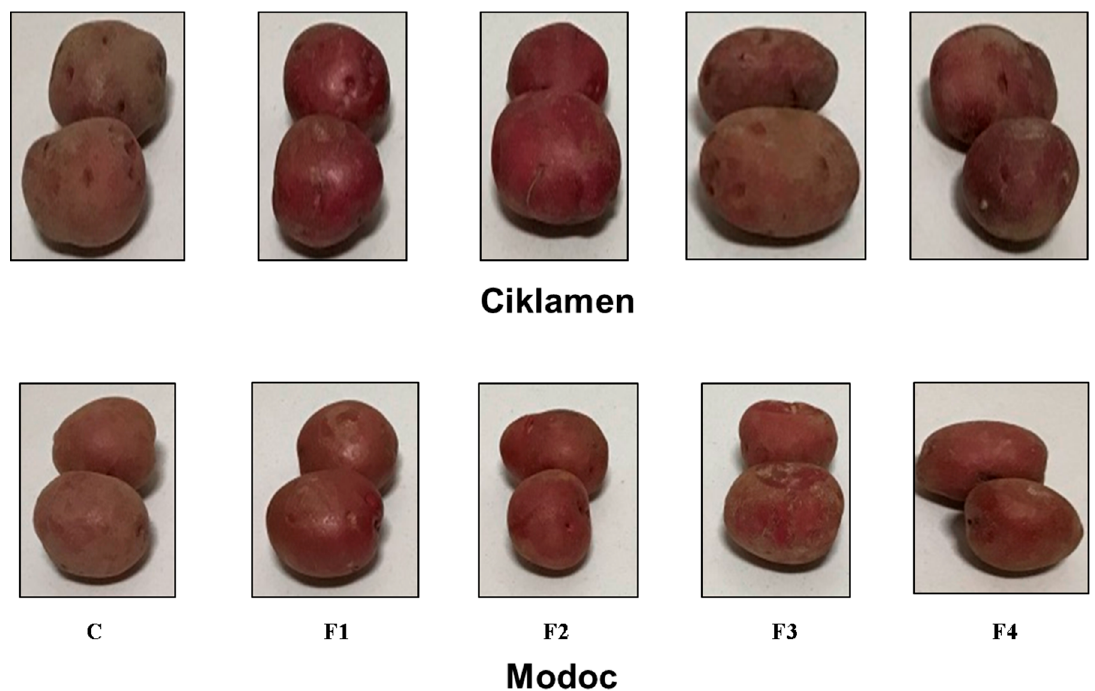
Figure 5. Effect of different edible coatings on the appearance of Cicklamen and Modac tubers after three months of cold storage at 4 ± 2 °C and 90 ± 5% RH. C: control. F1: sodium alginate. F2: potato starch + sodium alginate emulsion with oregano oil. F3: zein + chitosan emulsion with oregano oil. F4: potato starch + chitosan + sodium alginate emulsion with oregano oil.